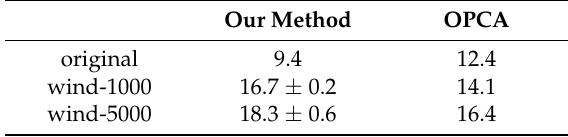
Table 2. The comparison of our method with the OPCA method on false positive rate.